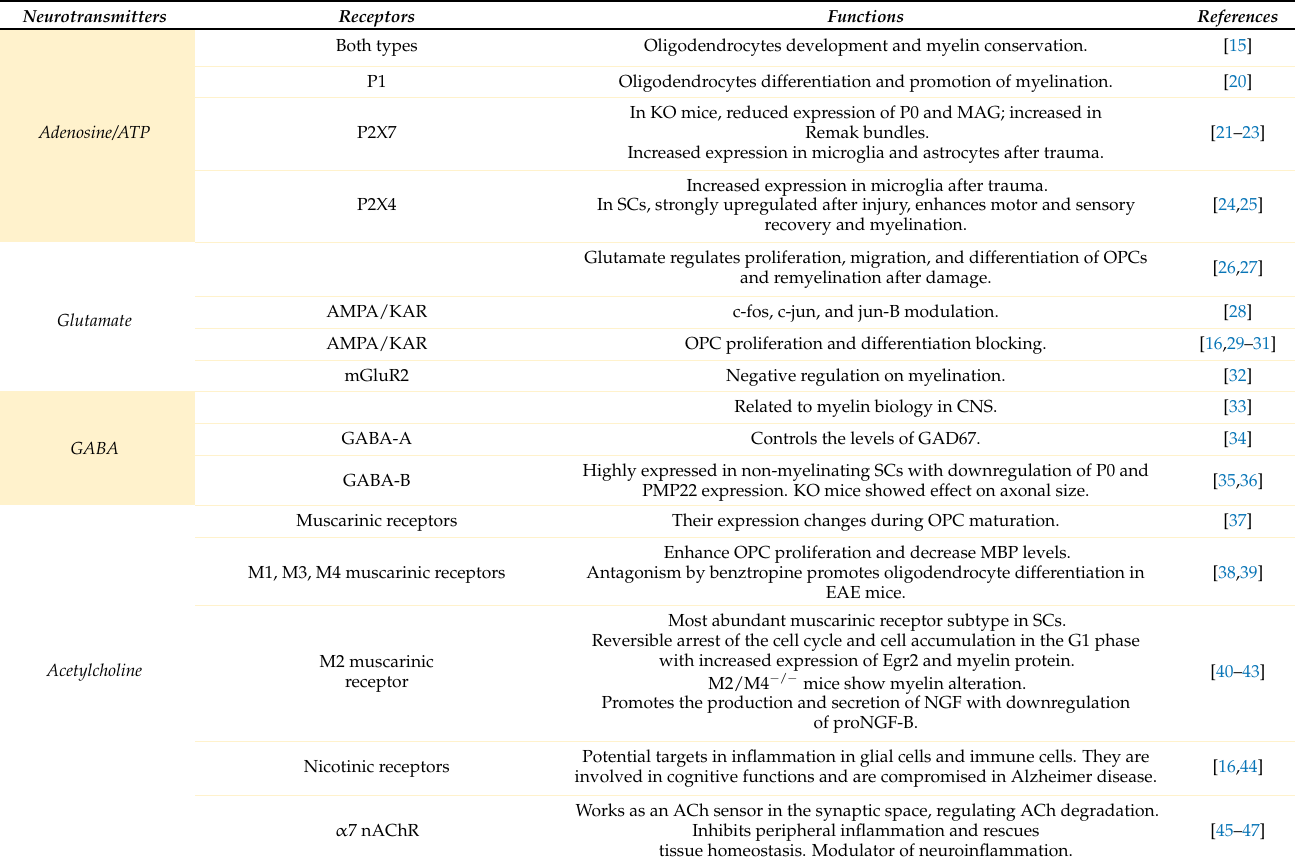
Table 1. Neurotransmitter expression and function in glial